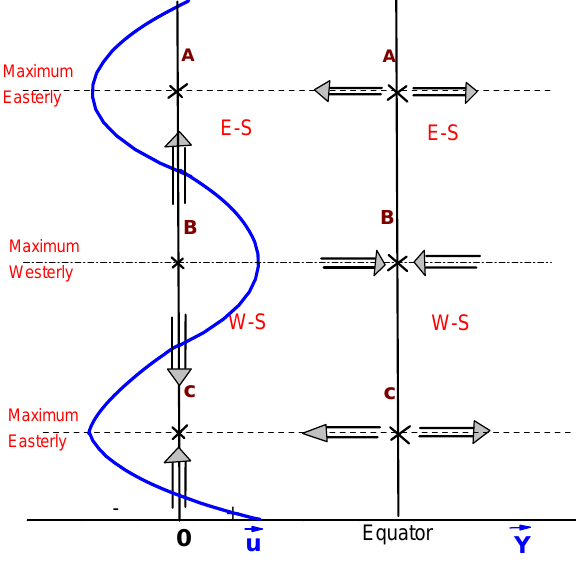
Fig. 8. Schematic vertical profiles of zonal winds, meridional diver- gence/convergence (reconstructed from Choi et al.,